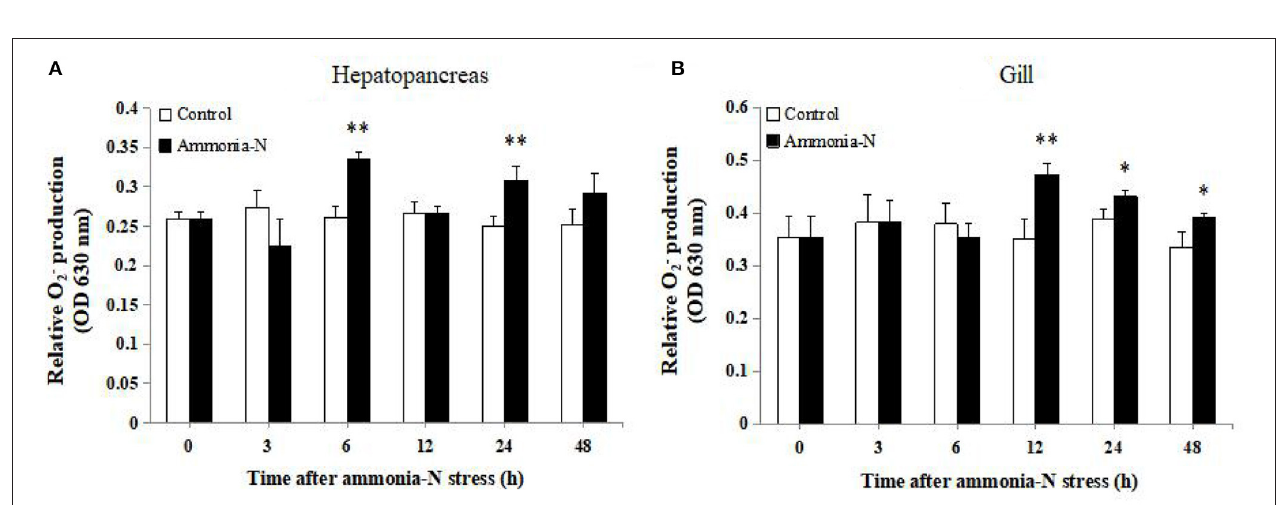
FIGURE 6 | Analysis of Grx 3 expression in (A) hepatopancreas and (B) gill of LPS-injected and control groups by quantitative real-time polymerase chain reaction (qRT-PCR) at 0, 3, 6, 12, 24, and 48h post injection ( n = 9). Statistical significance was calculated using Statistical Package for the Social Sciences (SPSS) 18.0 (* P < 0.05; ** P < 0.01).